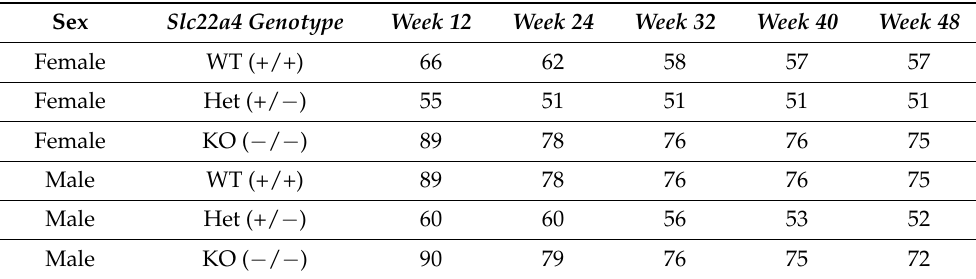
Table 1. Number of mice per condition and age used to assess the percentage of lithiasic mice in Figure 6.